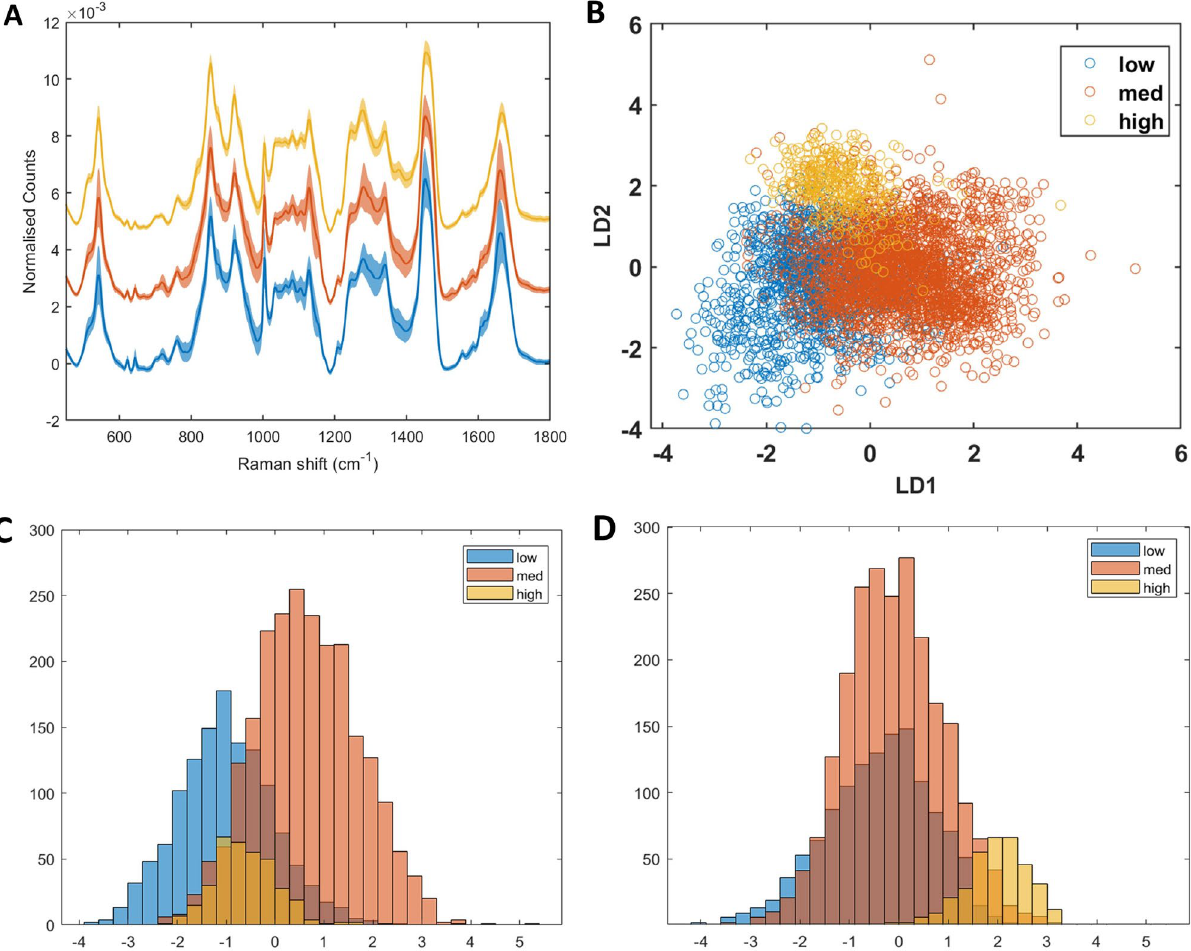
Figure 2. ( A ) Average Raman spectrum of CAPRA low group (blue), CAPRA medium (orange) and CAPRA high (yellow). Shadow spectrum represents + /− 1 standard deviation. ( B ) scatter plot of linear discriminant 1 (LD1) and linear discriminant 2 (LD2) scores obtained from RS-GBR-NMF-sparseLDA classification of RS acquired from Gleason score 6 (blue points), 7 (orange points) and 8 (yellow points). ( C ) Histogram of LD1 scores obtained from RS-GBR-NMF-sparseLDA classification of RS acquired from CAPRA low (blue points), CAPRA medium (orange points) and CAPRA high (yellow points). ( D ) Histogram of LD2 scores obtained from RS-GBR-NMF-sparseLDA classification of RS acquired from CAPRA low (blue points), CAPRA medium (orange points) and CAPRA high (yellow